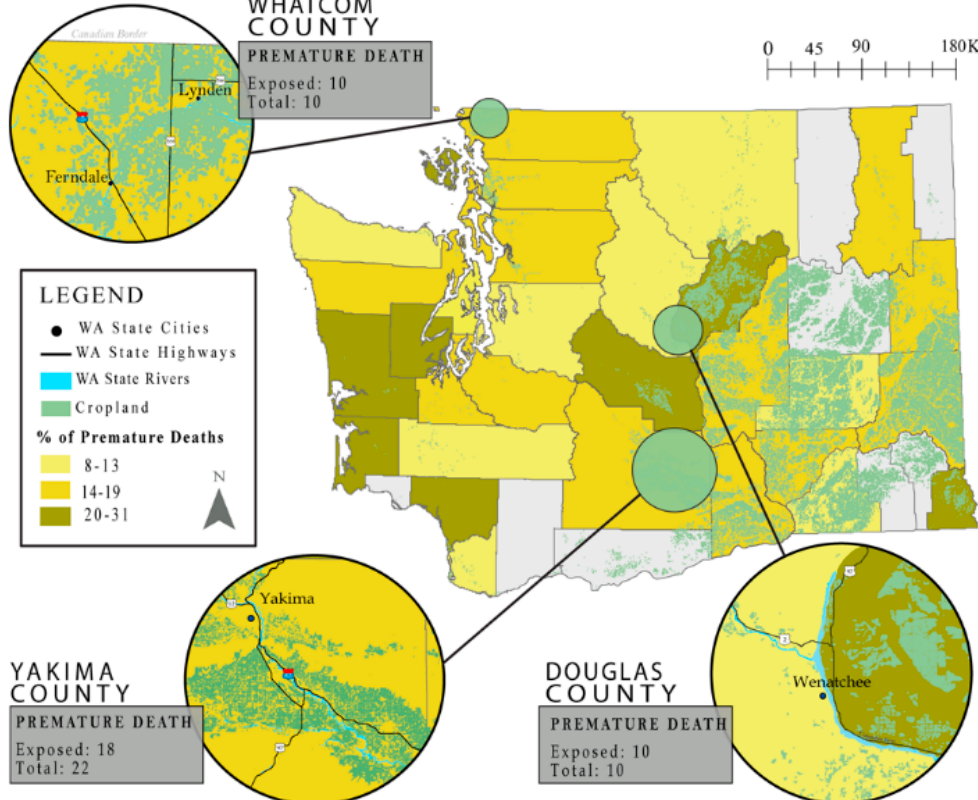
Figure 1. Percent premature death (659 of 4591 total deaths) at the county level, with inset maps of geographic areas that presented a high spatial correlation between the premature mortality and proximity to glyphosate and/or Paraquat application. Ratios can be described as the number of premature deaths within 1000 meters of application, divided by the total number of premature deaths. Grayed counties were excluded from analysis due to a small cell count.